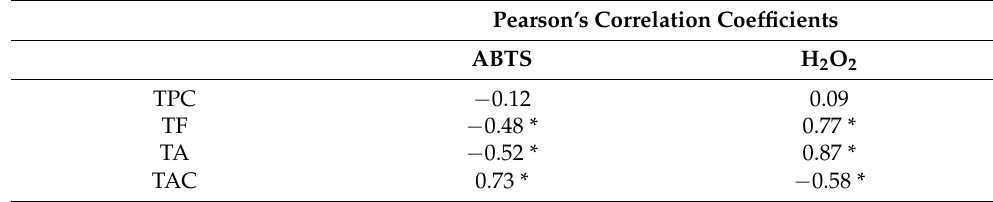
Table 5. Pearson’s correlation coefficients of ABTS and H 2 O 2 scavenging versus TPC, TF, TA and TAC.